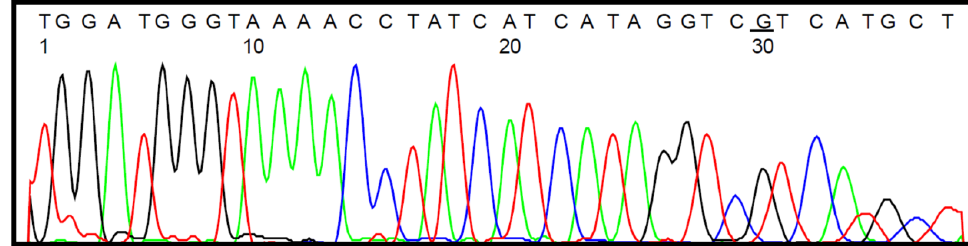
Figure 2. DNA sequencing data for IDH1 target amplicon showing wild-type IDH1 status of tumor sample # 9 derived from GBM patient (the nucleotide of interest is underlined); SNP accession number: rs121913500.